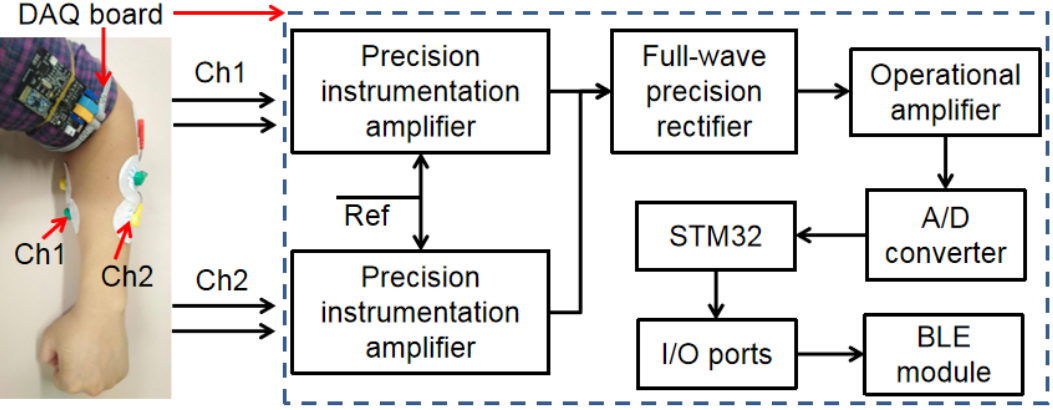
Figure 3. Two-channel block diagram of the electromyogram (EMG) hardware platform.